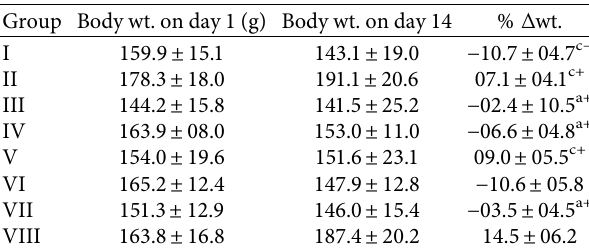
Table 7: Effect of repeated oral treatment with 50–400mg/kg/day of CVE on the average body weight of DOX-treated